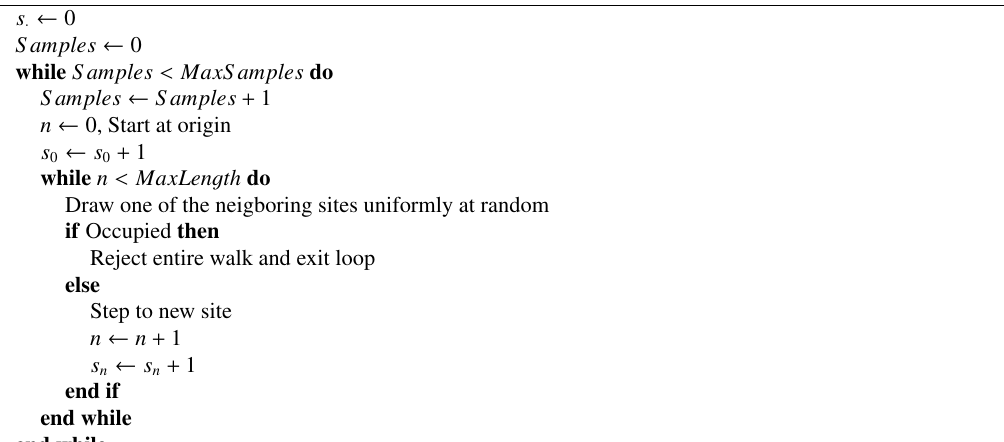
Algorithm 1 Simple Sampling of Self-Avoiding